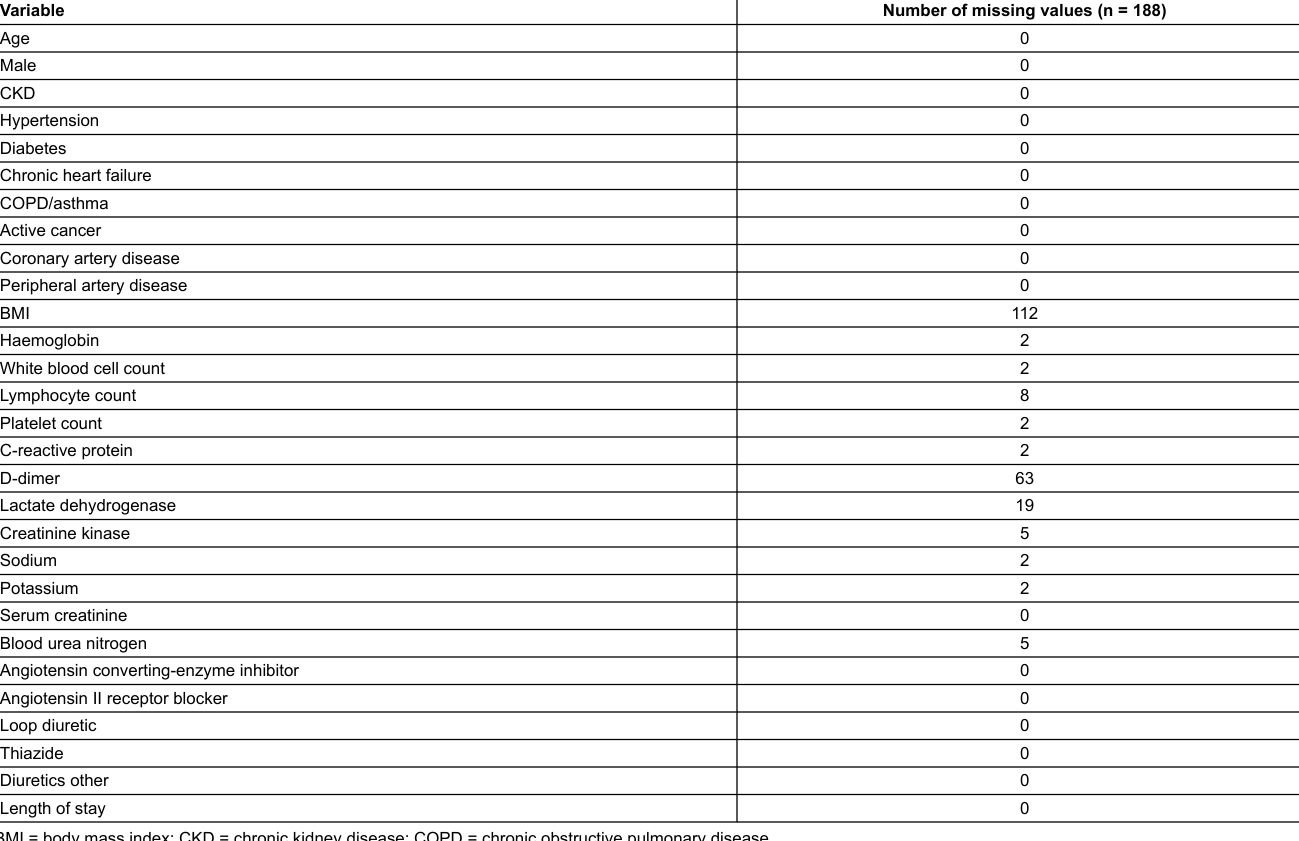
Table S2: Missing values.